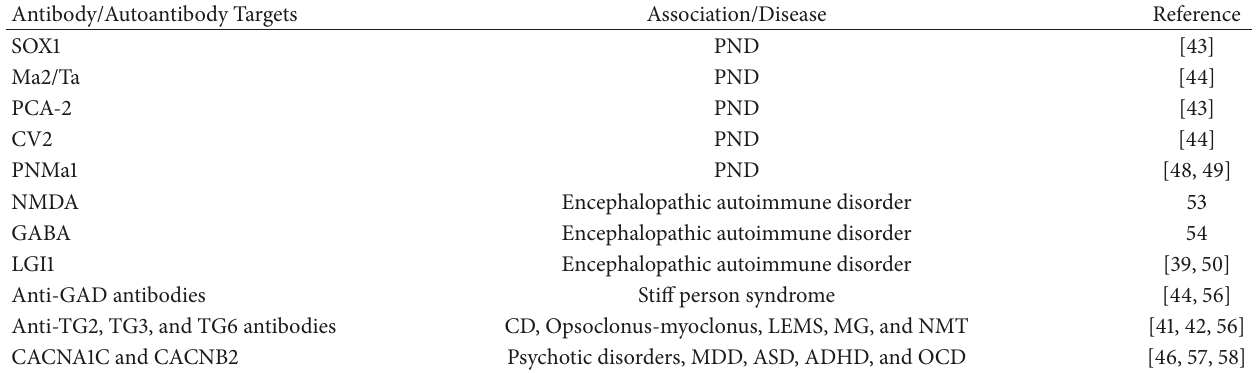
Table 3: Antibodies/Autoantibody Targets and Associated